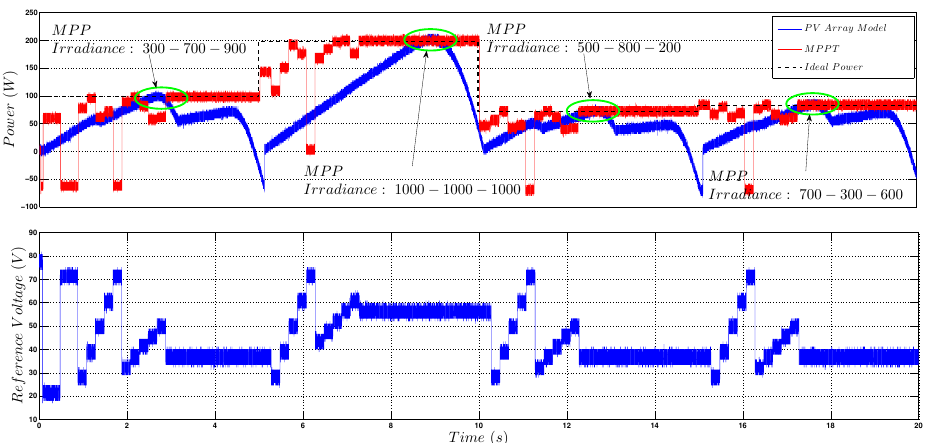
Figure 19. MPPT of the array of PV panel Solar-Sj65 with curves of the model generated by the